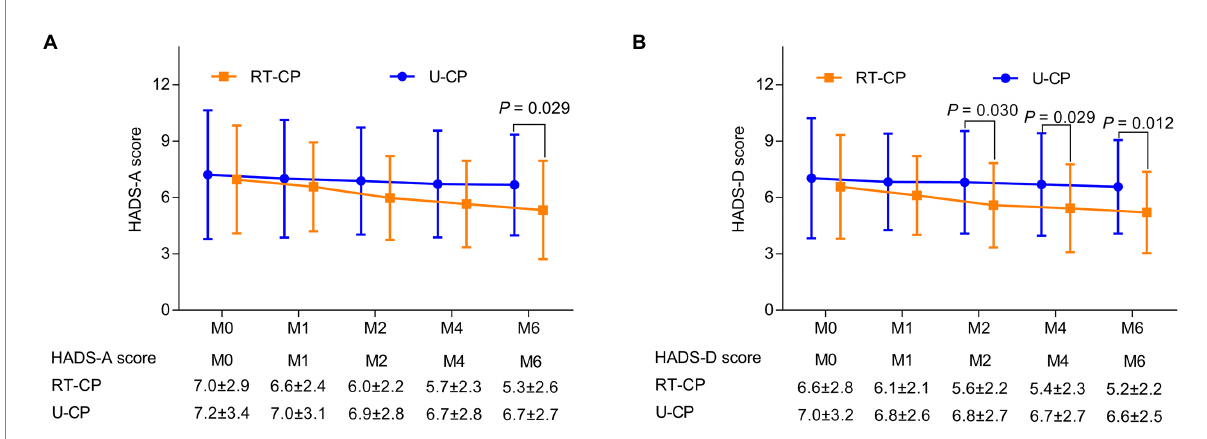
FIGURE 2 Comparison of Hospital Anxiety and Depression Scale (HADS) score at different time points between RT-CP group and U-CP group. HADS-A score at M6 was reduced in the RT-CP group in contrast with the U-CP group (A) ; HADS-D score at M2, M4, and M6 was decreased in the RT-CP group in comparison with the U-CP group (B) .